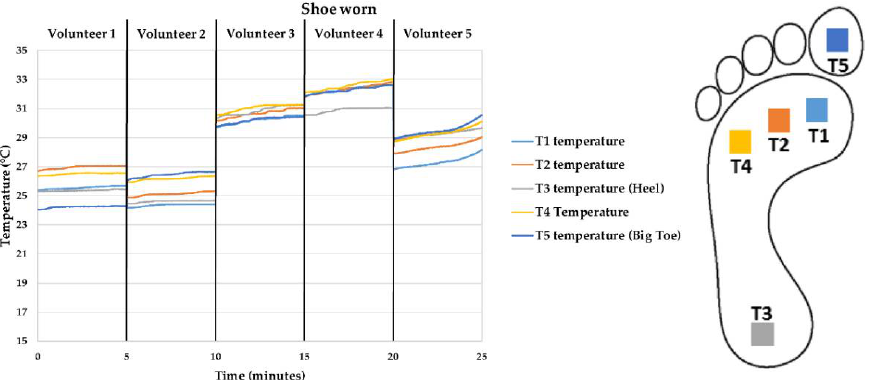
Figure 10. Temperature measurement from the temperature sensing sock when the sock was worn under a shoe for all of the volunteers.